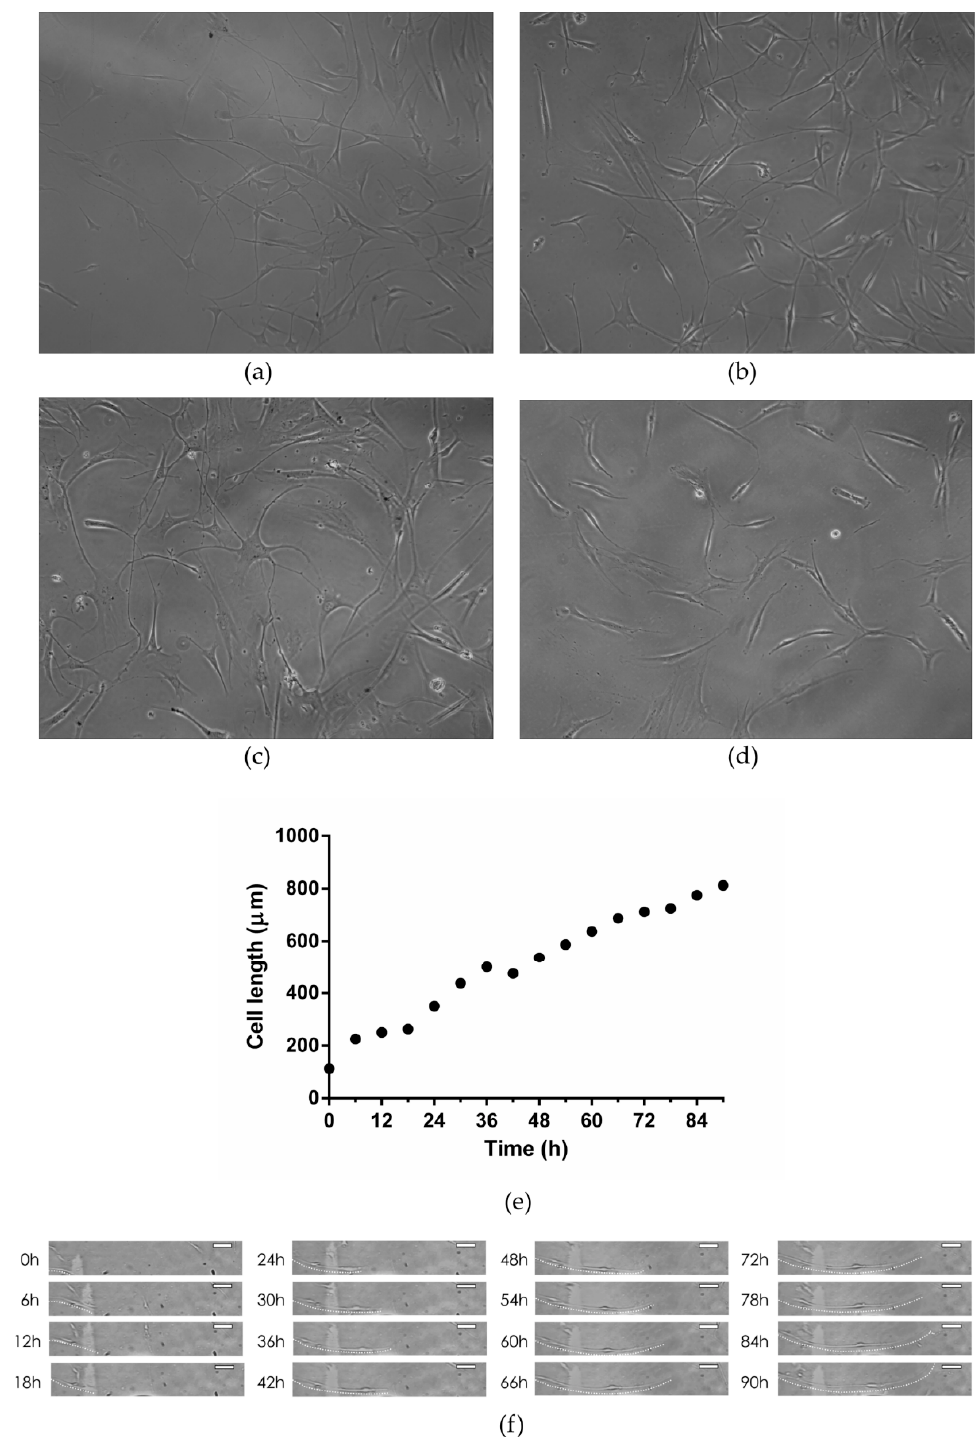
Figure 9. ( a – c ) Representative light micrographs of SCAP grown on graphene film; ( d ) Representative light micrograph of SCAP grown on PET; ( e ) Time-dependent changes in major axis length of SCAP grown on graphene film; ( f ) Time-lapse light micrographs of SCAP grown on graphene film (dotted white line represents cell extension pathway; white scale bar represents 100 µm).